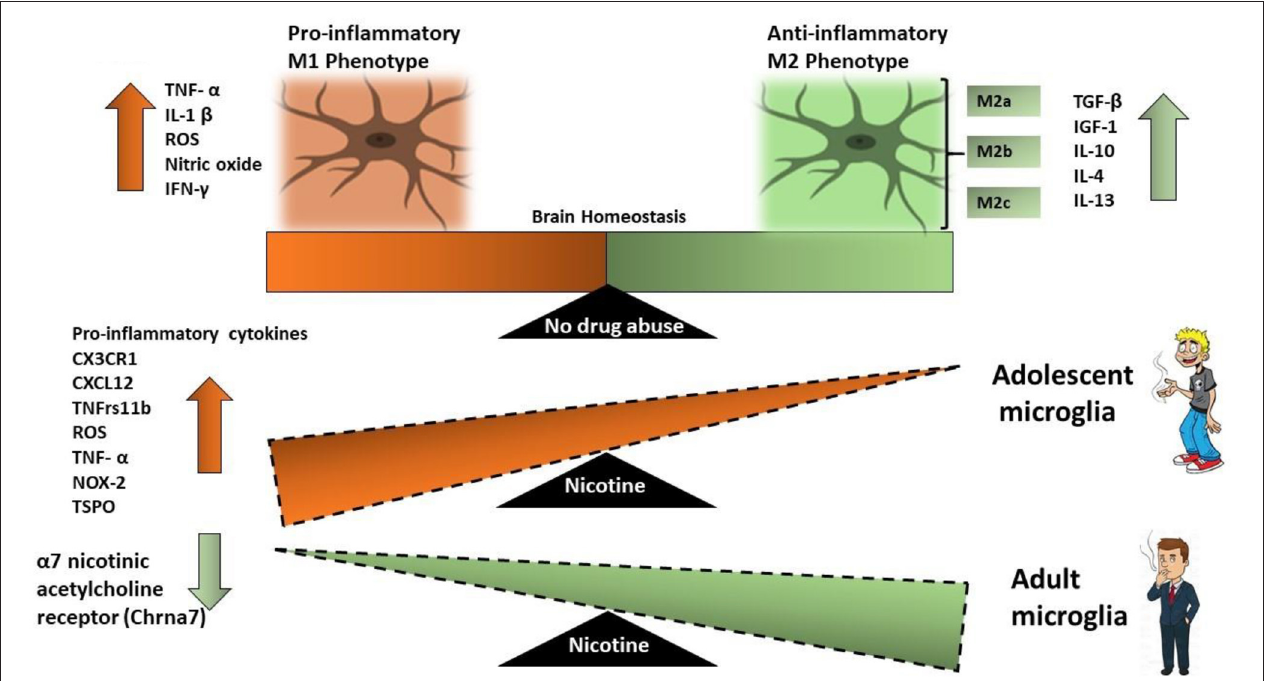
FIGURE 2 | Schematic that illustrates the effect of nicotine on microglial activation in adult microglia vs. adolescent microglia. M1 microglia represent a neurotoxic environment with increased levels of pro-inflammatory cytokines while M2 microglia are neuroprotective. Adolescent-nicotine exposed microglia show an increased reactive M1 activation and a pro-inflammatory response. Increased expression of pro-inflammatory cytokines CX3CR1, CXCL12, TNFrs11 β , ROS, NOX-2, TNF- α , and TSPO are reported in nicotine exposed adolescent microglia as compared to nicotine exposed adult